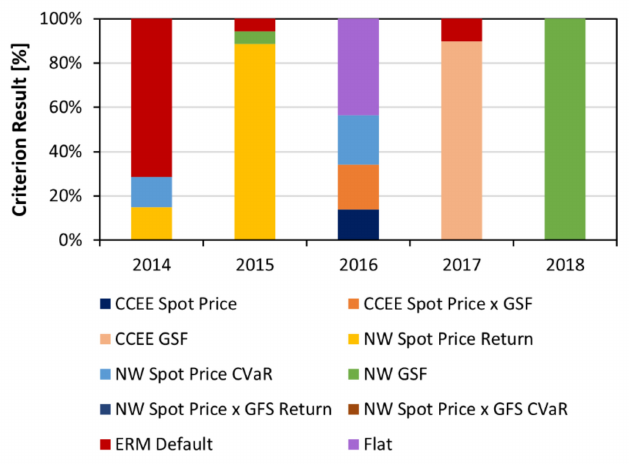
Figure 8. Results obtained for utility